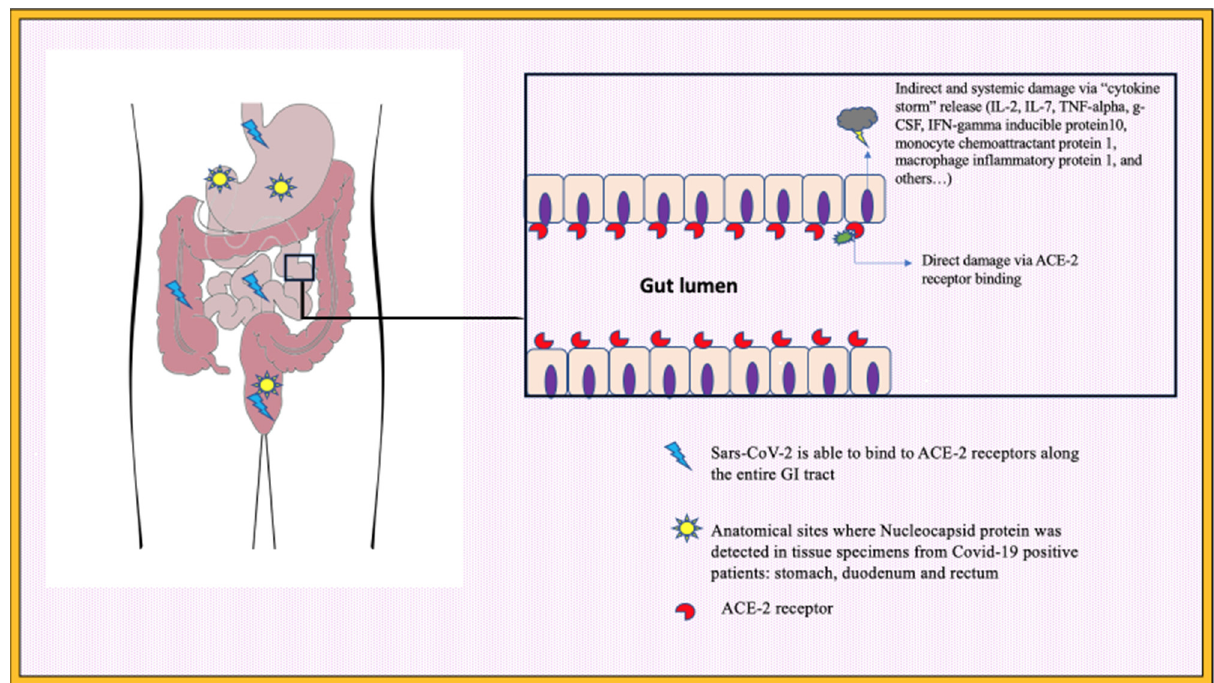
Figure 2. Simpli fi ed representation of mechanisms of SARS-CoV-2-related damage and histopathol- Figure 2. Simplified representation of mechanisms of SARS-CoV-2-related damage and histopathol- ogy fi ndings in COVID-19 patients with GI symptoms. ogy findings in COVID-19 patients with GI